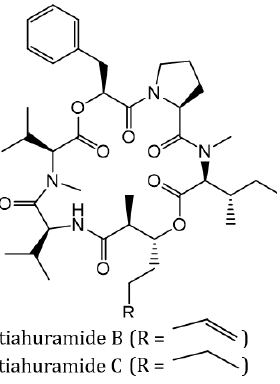
Figure 11. Structure of tiahuramides B-C The cyclodepsipeptides veraguamides